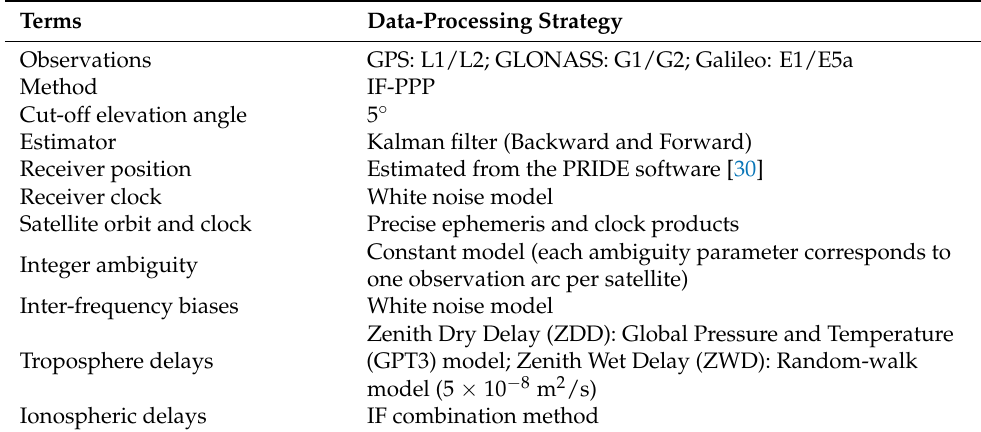
Table 2. The specific data-processing strategy of the IF-PPP method for GNSS dual-frequency obser-